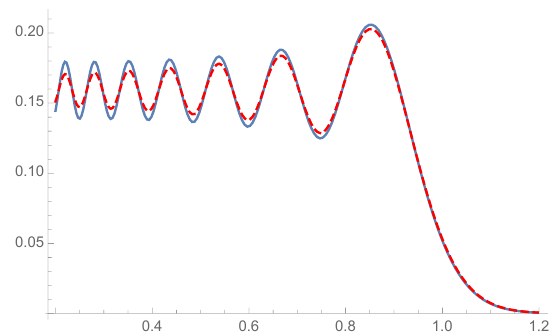
Figure 7 . The improved Balazs-Zipfel approximation to the quantum distribution of non- interacting fermions at zero temperature in a harmonic potential, (A.19) (dashed line), compared to the exact function (full line), as a function of H ( x; p ), for N = 30, ~ = 1 = 30, and (cid:24) = W N